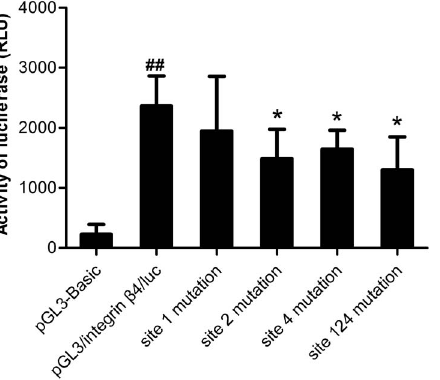
Figure 2. Mutants were generated in a luciferase reporter plasmid. The results showed that luciferase activities decreased after mutating the site2, site4, and remarkably decreased after mutating site124 together. Relative activities of luciferase were equal to the fluorescence intensity of firefly when activities of Renilla were equal to 1. Data are means 6 SD of 4 experiments. *P , 0.05 versus pGL3/integrin b 4/luc, ## P , 0.01 versus pGL3-Basic. doi:10.1371/journal.pone.0095533.g002 PLOS ONE |